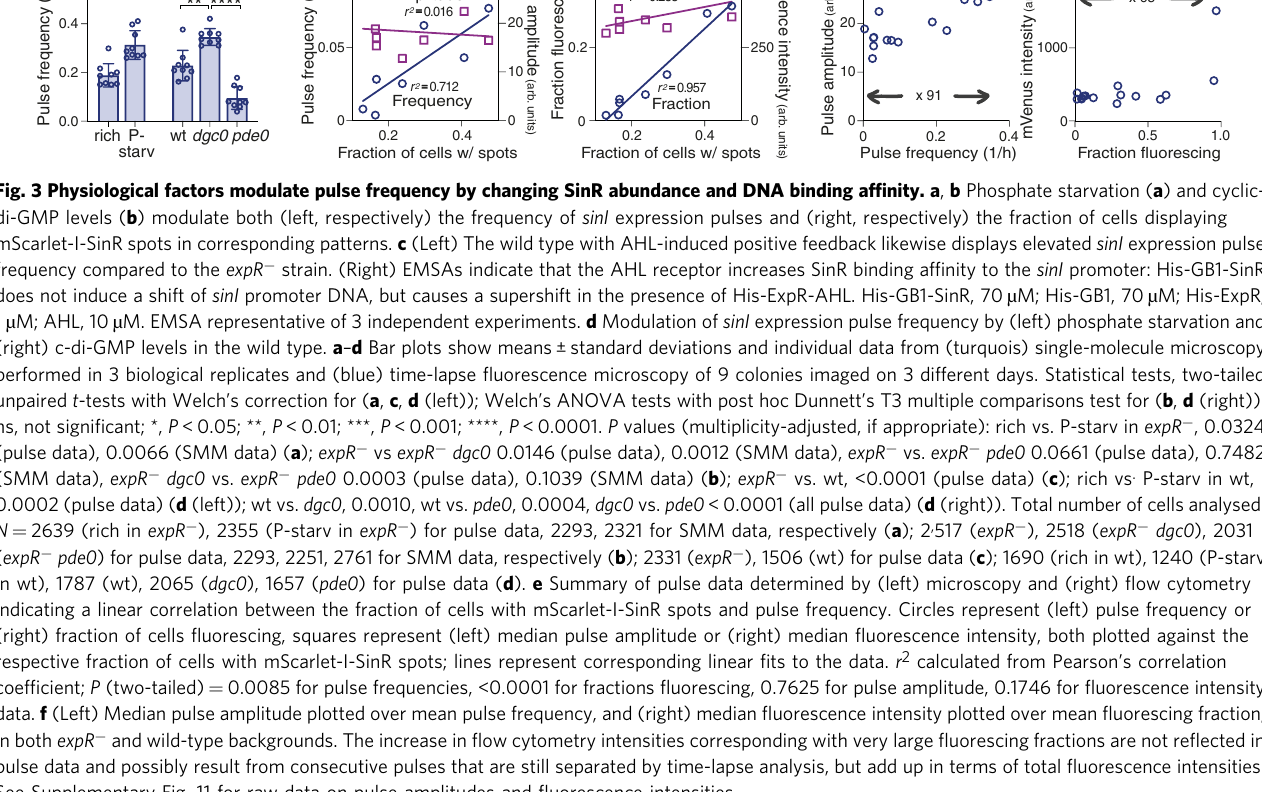
indicating a linear correlation between the fraction of cells with mScarlet-I-SinR spots and pulse frequency. Circles represent (left) pulse frequency or (right) fraction of cells fl uorescing, squares represent (left) median pulse amplitude or (right) median fl uorescence intensity, both plotted against the respective fraction of cells with mScarlet-I-SinR spots; lines represent corresponding linear fi ts to the data. r 2 calculated from Pearson ’ s correlation coef fi cient; P (two-tailed) = 0.0085 for pulse frequencies, <0.0001 for fractions fl uorescing, 0.7625 for pulse amplitude, 0.1746 for fl uorescence intensity data. f (Left) Median pulse amplitude plotted over mean pulse frequency, and (right) median fl uorescence intensity plotted over mean fl uorescing fraction, in both expR − and wild-type backgrounds. The increase in fl ow cytometry intensities corresponding with very large fl uorescing fractions are not re fl ected in pulse data and possibly result from consecutive pulses that are still separated by time-lapse analysis, but add up in terms of total fl uorescence intensities. See Supplementary Fig. 11 for raw data on pulse amplitudes and fl uorescence